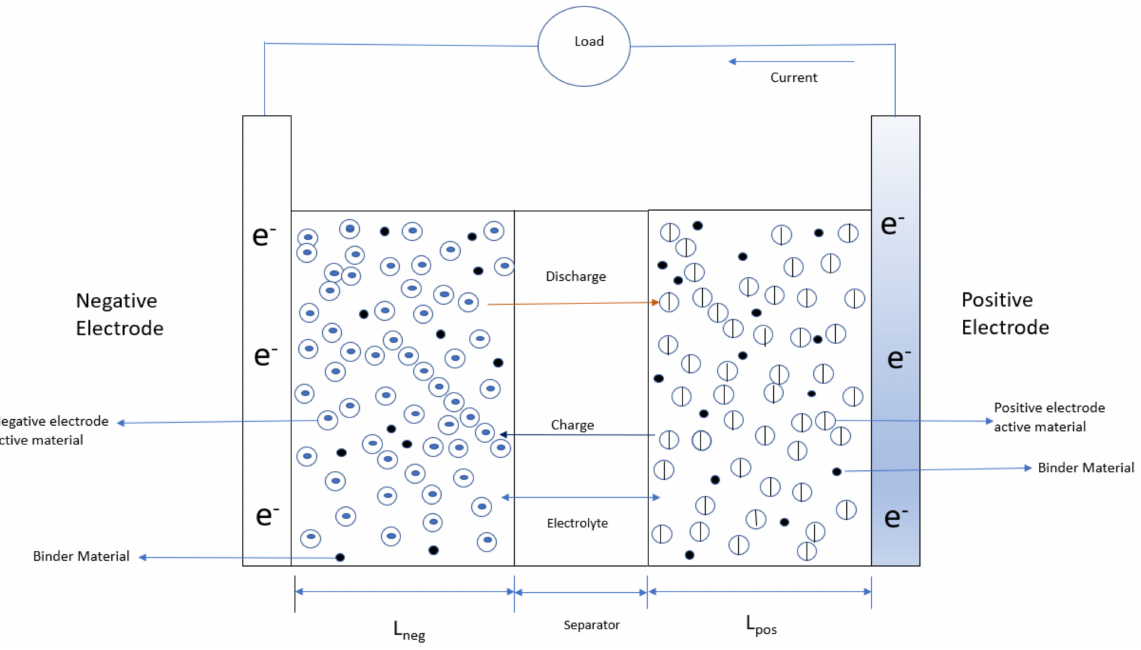
Figure 1. Two-dimensional representation of the five regions of the